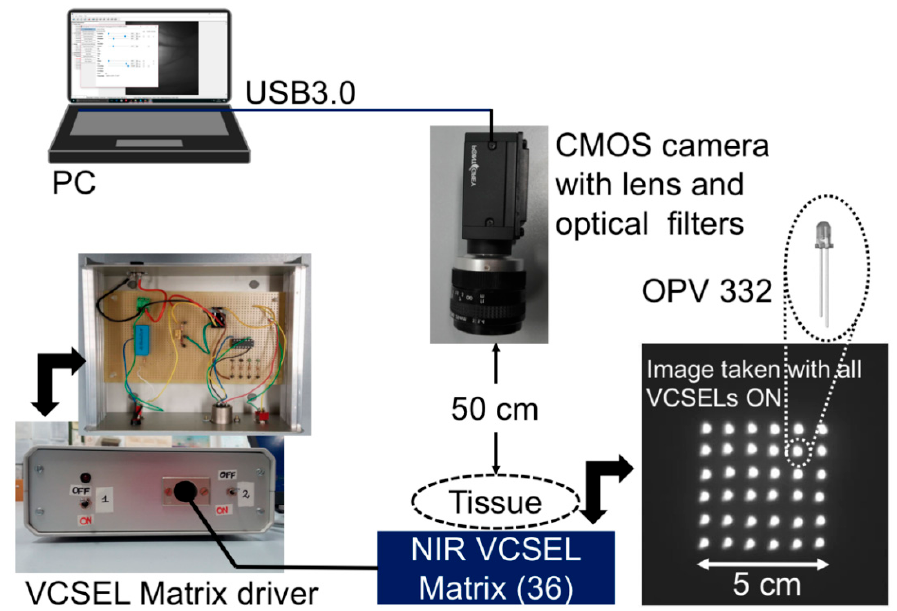
Figure 1. Instrumental configuration of the portable system for infrared transillumination.